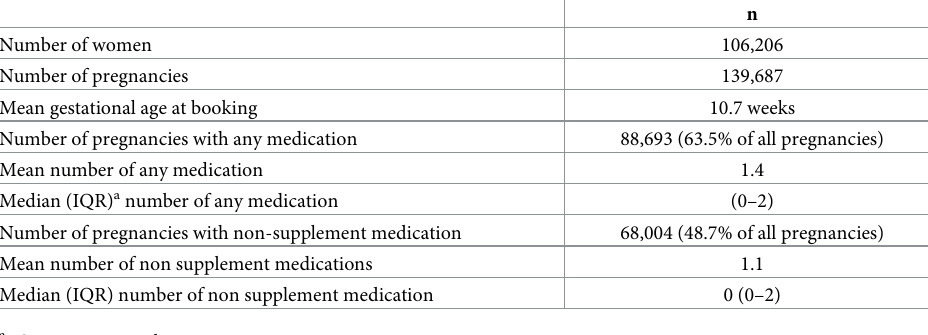
Table 1. Number of women, number of pregnancies, and number, mean, and percentage of pregnancies with any medication and non-supplement medication dispensed from EPD.